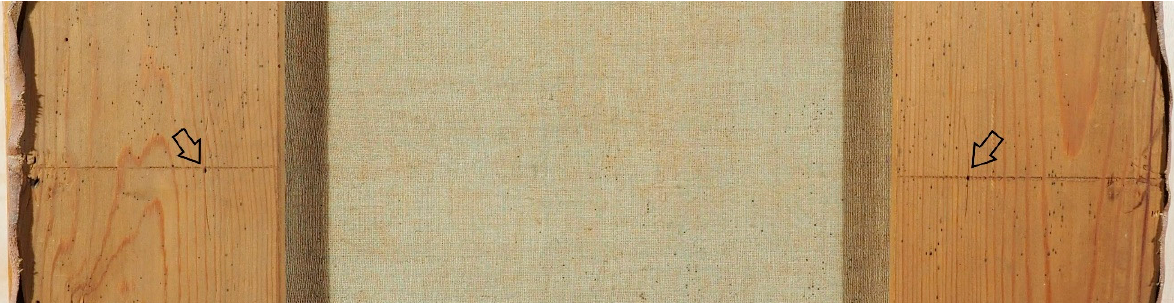
strainer on of E. Moltke (SV6). Similar holes and positioning on the minor axis are also visible on the strainers of A.M.B. Neergaard (SV2), J.P.B. Neergaard (SV4), and J. Moltke